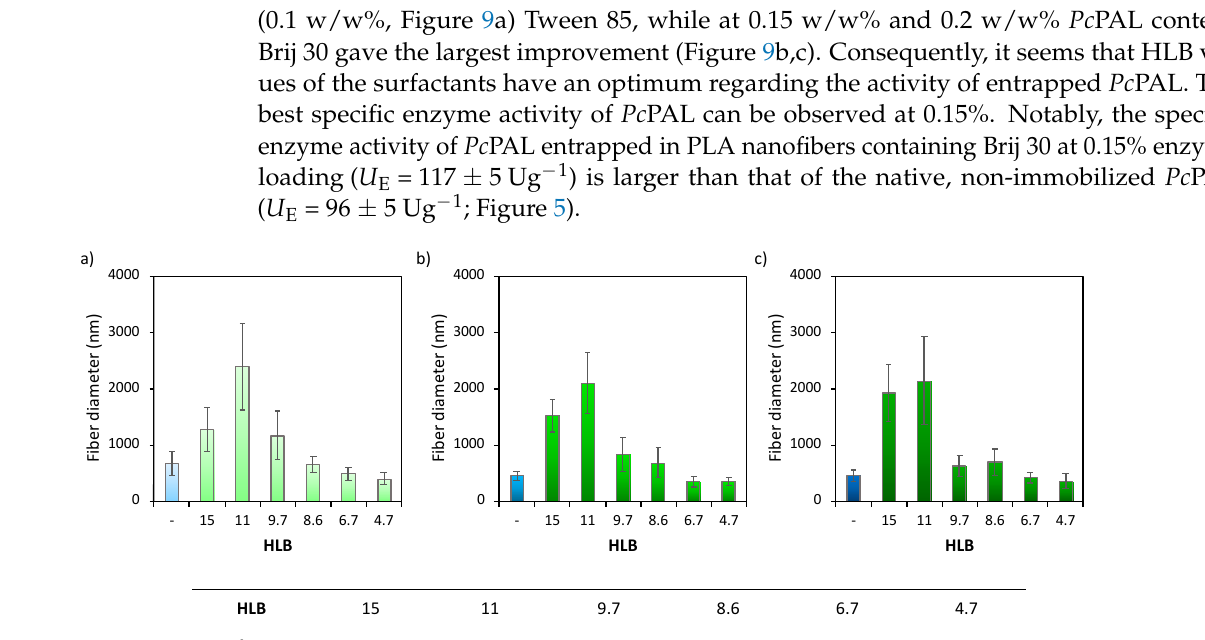
Figure 8. The effect of the surfactants (Tween 80, Tween 85, Brij 30, Span 20, Span 40, and Span 60) with different HLB values on the diameter of Pc PAL loaded PLA nanofibers at different Pc PAL loading: ( a ) 0.10, ( b ) 0.15, and ( c ) 0.20 w/w%. Size distribution of fibers was calculated from n = 50 measurements, the difference between emulsifier-free (colored with blue bars on Panel ( a – c ) and samples with emulsifier is significant ( p < 0.005) in all cases, except samples with Span 20 at Pc PAL loading 0.10 w/w% and Span 40 at Pc PAL loading 0.20 w/w%.